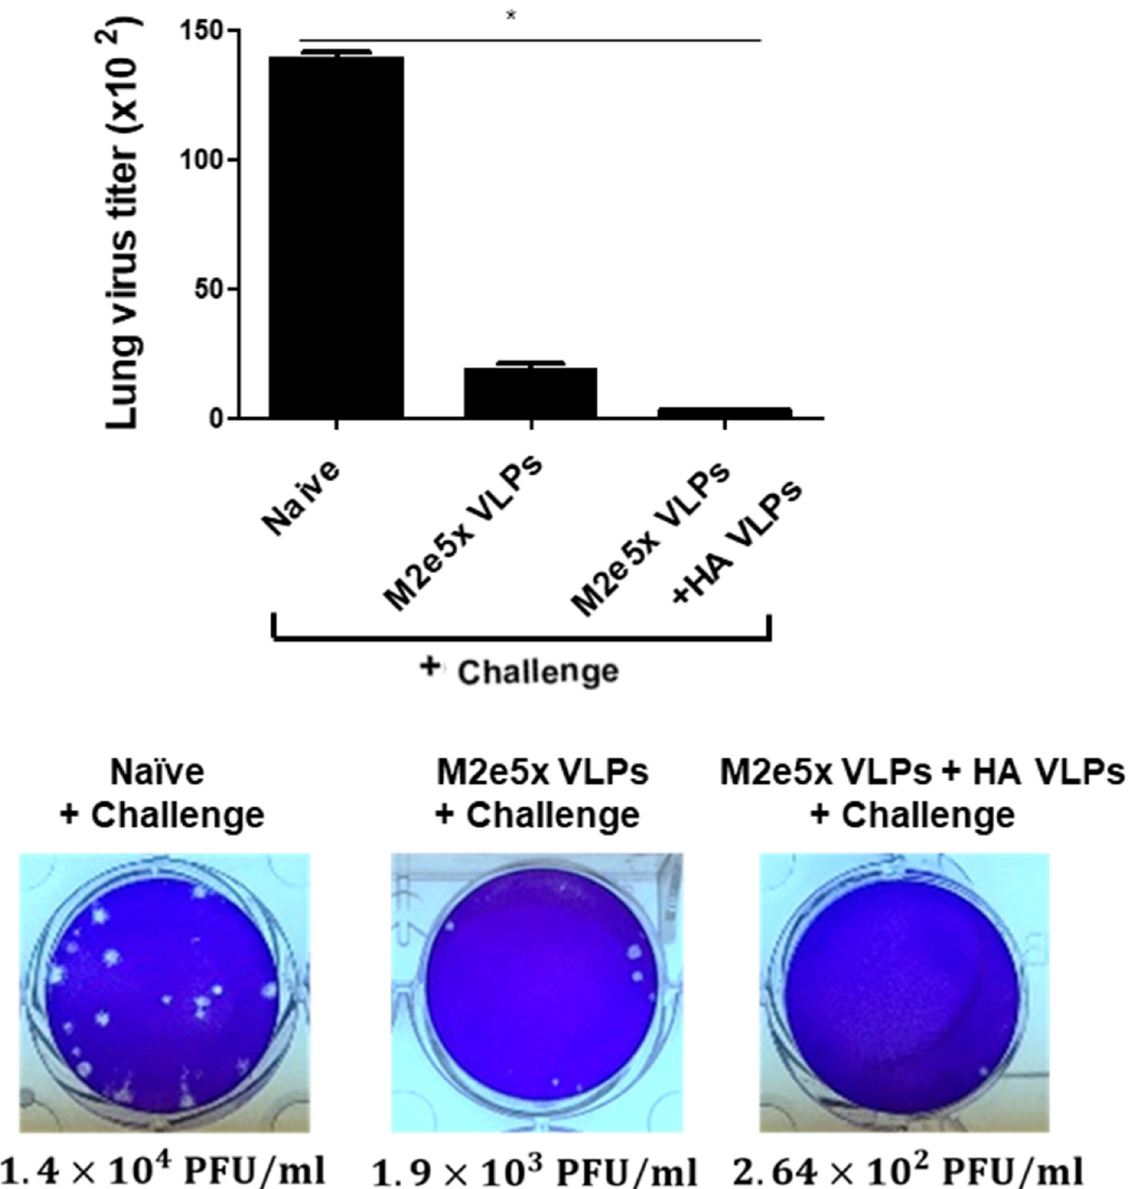
Fig 7. Lung viral titers. Lung samples from individual mouse immunized with VLPs and Na ï ve + Challenge were collected on day 4 post infection with a lethal dose of A/Viet Nam/1203/2004 (rgH5N1) virus. Significantly lower levels of lung virus loads were found in combinatorial VLPs group compared to M2e5x VLPs group and Na ï ve + Challenge group ( � P < 0.05). Data are expressed as mean ± SD. inflammatory cytokine IL-6. We observed that VLP vaccinated mice showed lower lung virus titers (Fig 7), indicating there is an inverse correlation between lung viral titers and the levels of inflammatory. The results indicated that higher vaccine efficacy from VLP immunization showed lower proinflammatory cytokine response. This is consistent with previous our and other studies demonstrating that immunized mice showing higher efficacy (lower lung viral titers) show lower proinflammatory cytokines (IFN- γ and IL-6) in the lungs of mice than non- immunized mice upon infection with influenza virus [18,25,30]. It is a different measure for